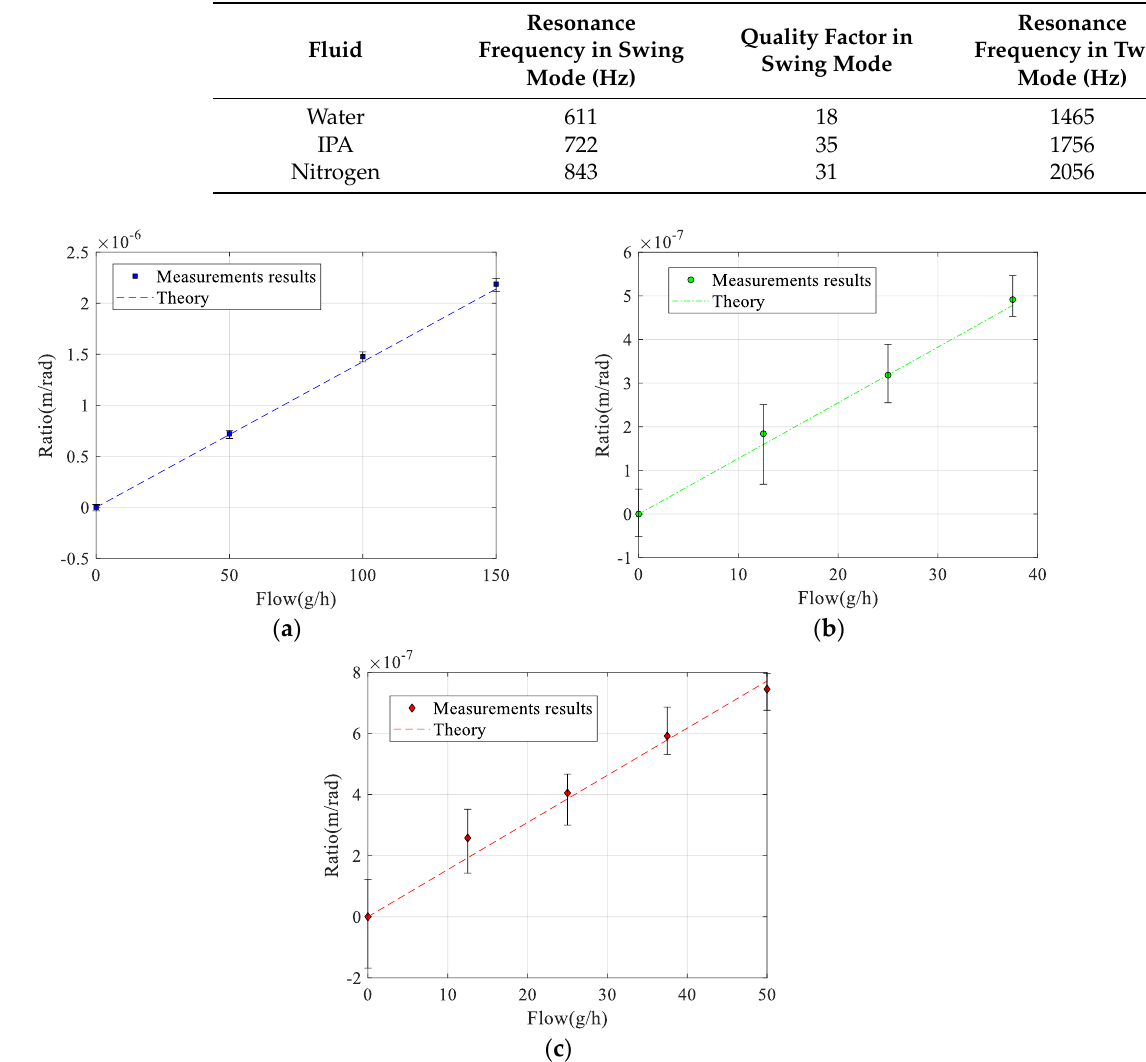
Figure 9. Measured and theoretical ratio between the Coriolis motion and the actuation amplitude according to Equations (29) and (14), respectively, as a function of mass flow of ( a ) water, ( b ) IPA, and ( c ) nitrogen. For all fluids, the same correction factor of 0.6 was applied to the model (14) such that the theoretical response matches the measurement results.